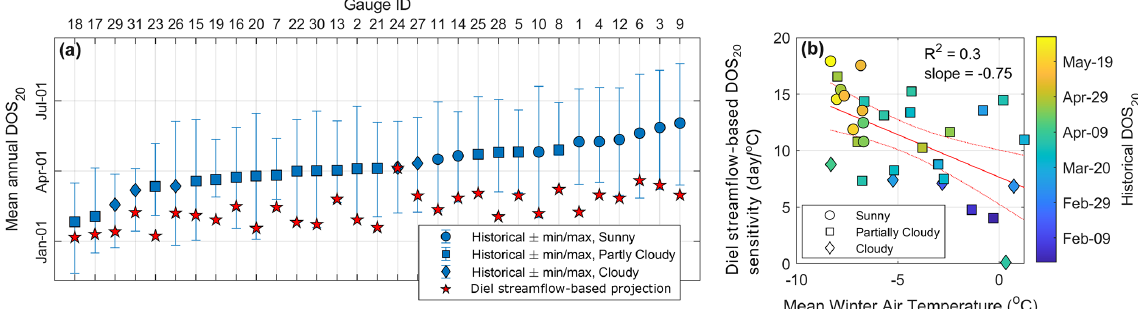
Figure 8. (a) Historical DOS 20 from the diel analysis and projected changes in DOS 20 using the empirical diel streamflow-based projections under the RCP8.5 pseudo global warming climate for the end of the 21st century. Watersheds are sorted from earlier (left) to later (right) historical DOS 20 . Symbols associated with future projections (stars) are not classified by sunny, partly cloudy, or cloudy conditions, as we make no inference about the cloudiness condition of snowmelt days under the climate change scenario. Blue symbols in panel (a) represent the mean annual percentage of clear-sky snowmelt days, where sunny sites (circles) have > 90% clear-sky snowmelt days, partly cloudy sites (squares) have between 70% and 90%, and cloudy sites (diamonds) have < 70%. Clear-sky snowmelt days are defined as those with more than 80% of the potential clear-sky solar radiation. (b) Relationship between mean winter air temperature and the sensitivity of DOS 20 to climate change, as projected by the empirical diel streamflow-based